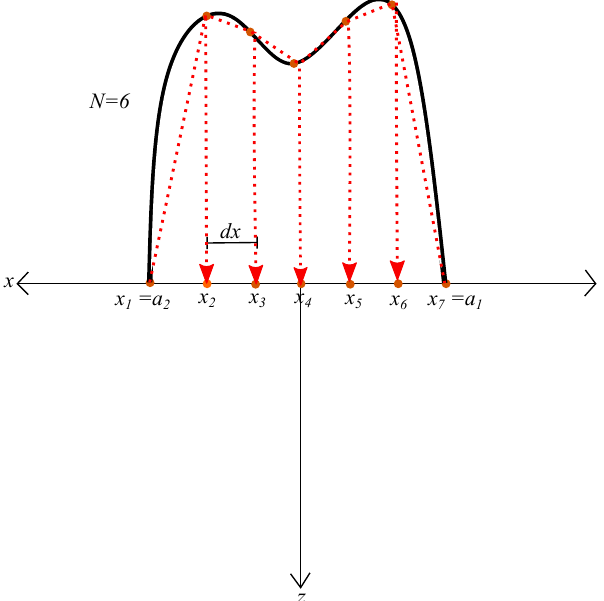
Figure 3. An example of the discretization of the loaded domain and the interpolation of a traction field using linear